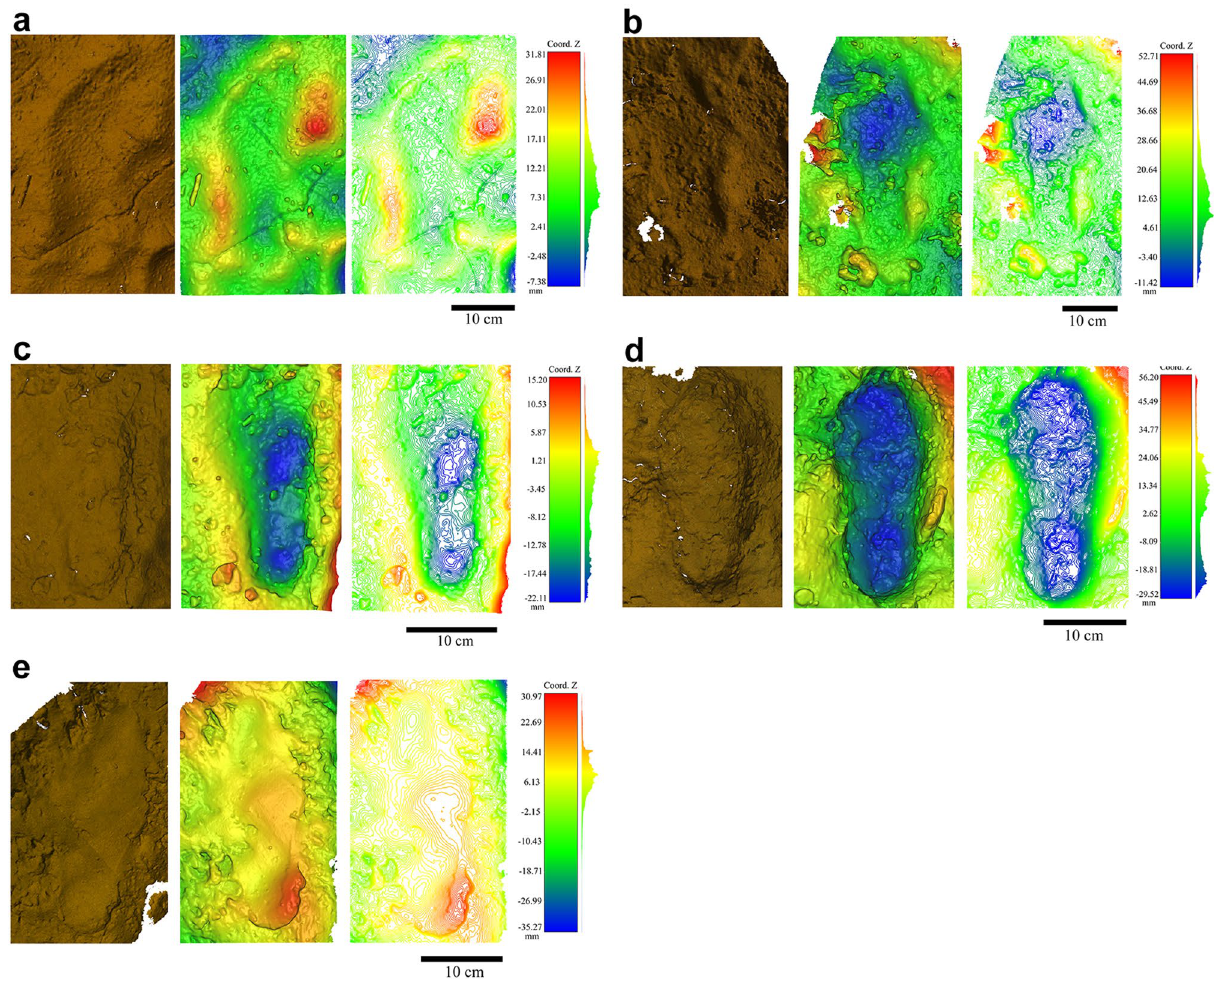
Figure 3. True colour images, depth maps and contour maps of the Cussac footprints. ( a ) T166; ( b ) T321; ( c ) T388-1; ( d ) T388-4; ( e ) T544.